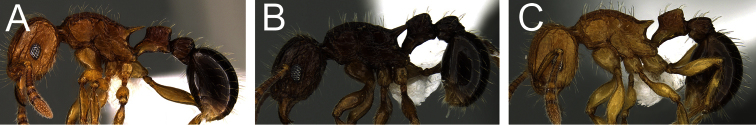
Variations of Tetramorium hecate. A bicoloured form with long propodeal spines (CASENT0248334) B uniform brown coloured form with long propodeal spines (CASENT0235157) C bicoloured form with short propodeal spines (CASENT0235154).